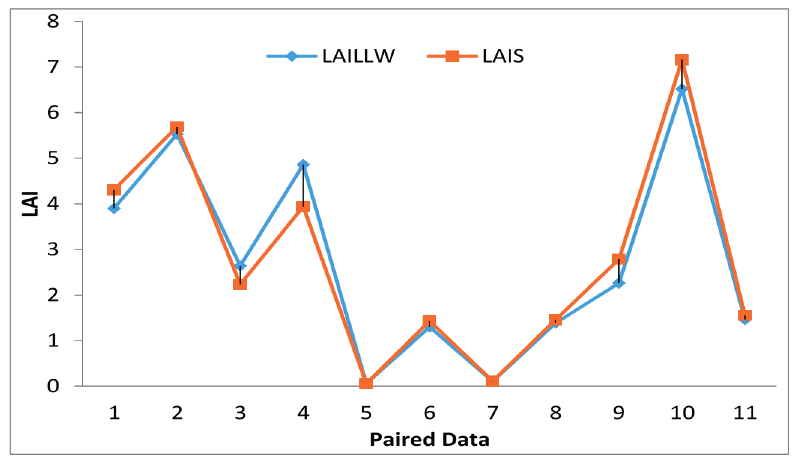
Figure 12. Comparison of LAI from LAILLW and LAIS.